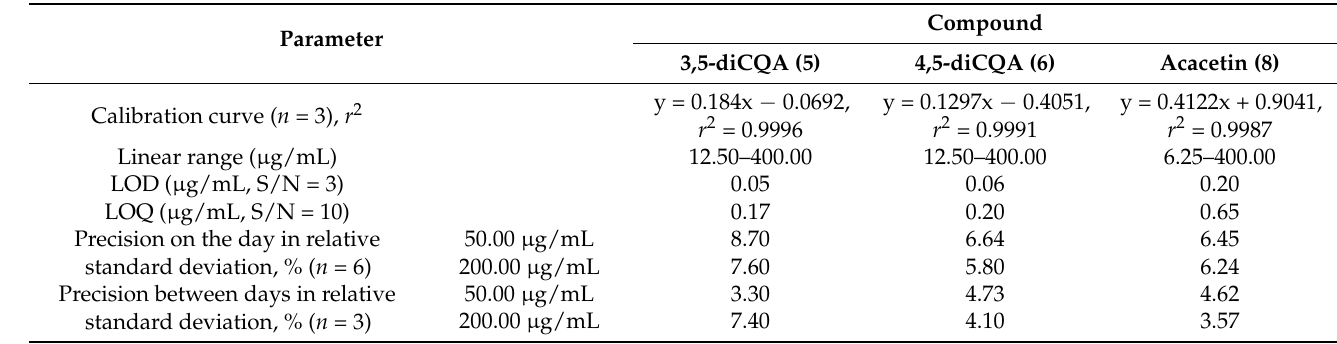
Table 6. Calibration curve, LOD, LOQ, repeatability, and reproducibility test of the three major compounds in the 70% MeOH root extract of V. rigida